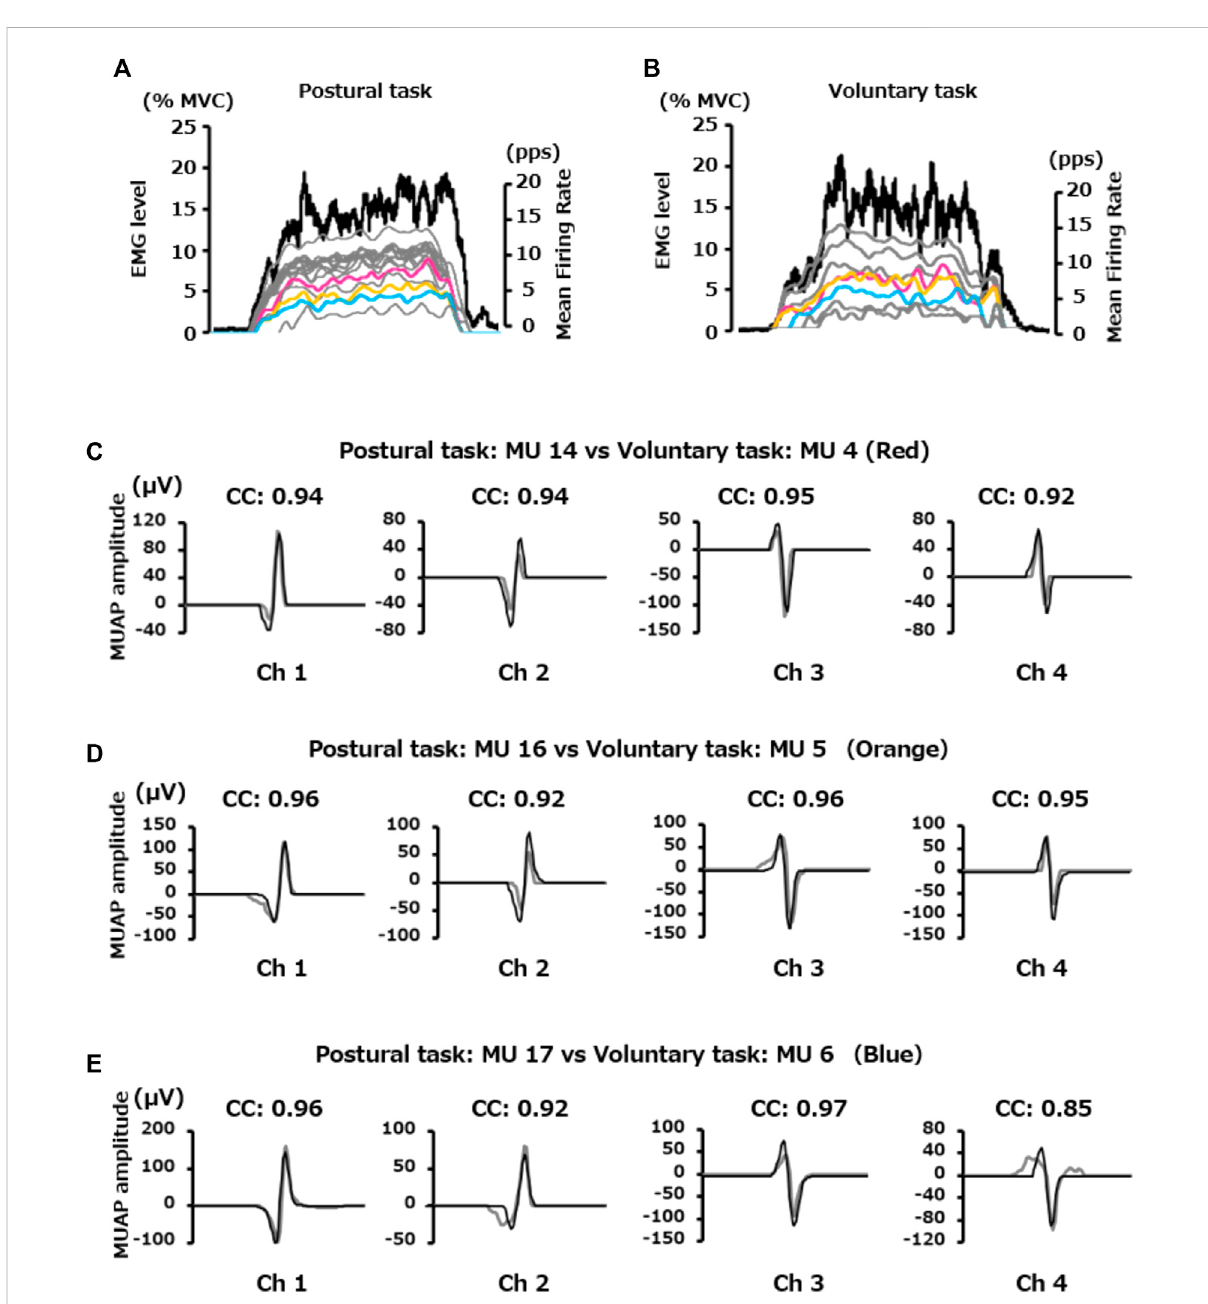
FIGURE 5 Difference in the fi ring properties of the motor units identi fi ed as identical between the two motor tasks. The upper two fi gures show the EMG level(blackline)exertedin (A) posturaland (B) voluntarytasksandthechangeinthe fi ringrateofeachmotorunit.Red,orange,andbluelinesindicate motor units shared by the two motor tasks, while the grey lines indicate motor units extracted independently from each motor task. Three pairs of motor units were identi fi ed as the same ones between two motor tasks (C – E) . The black and grey lines indicate the shape of the motor units in thepostural and voluntary tasks, respectively. The values represent the cross correlation (CC) of theshape of the motor units in thetwo motor